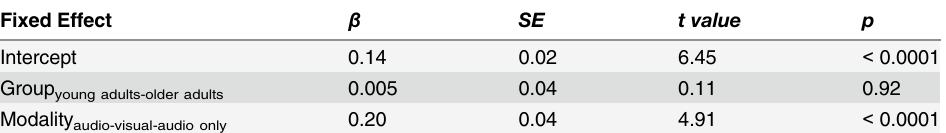
Table 6. Results of the effect of group and presentation modality on relative meaningful benefit at -12